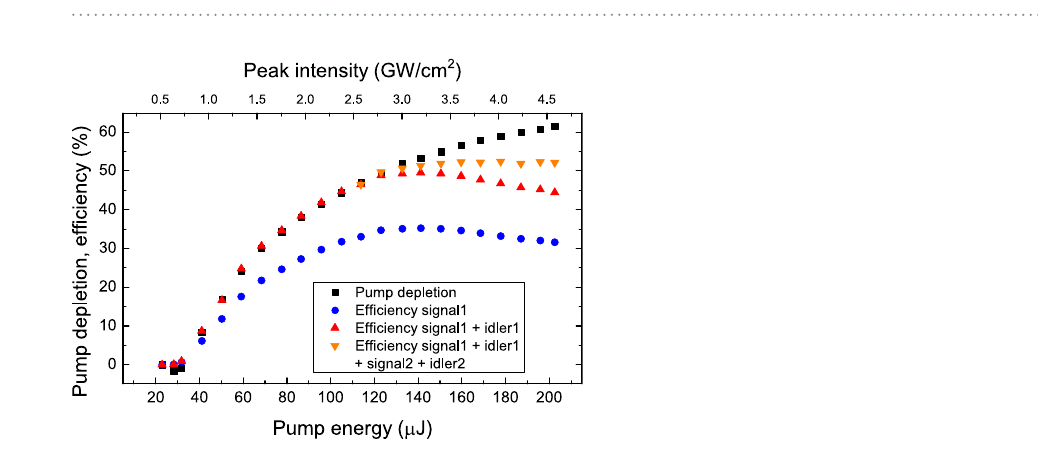
Figure 3. Sub- µ m PPRKTP domain structure. Atomic force microscope image of the chemically etched ( a ) former patterned face and ( b ) former unpatterned face of a representative PPRKTP crystal.